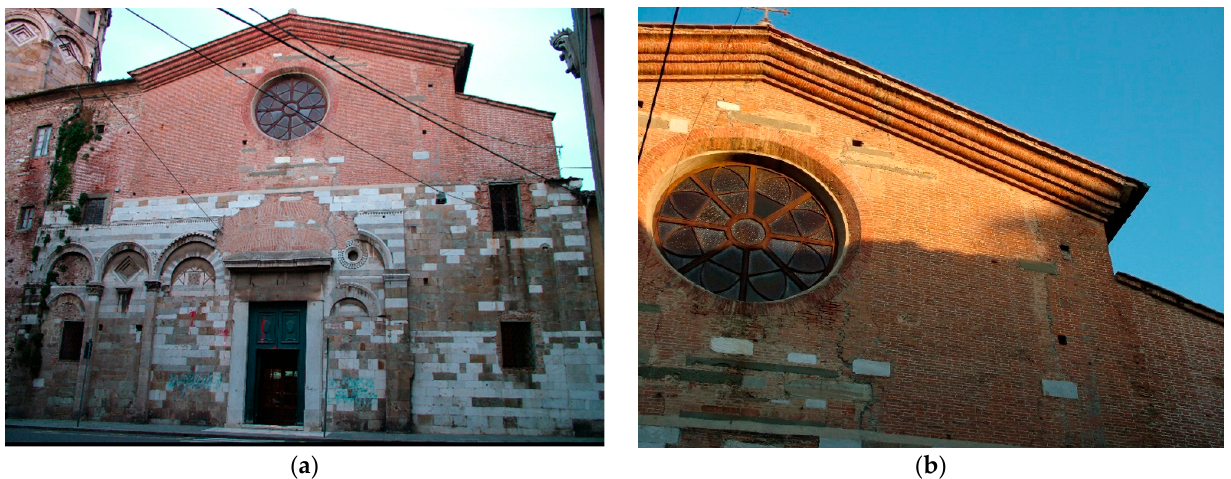
Figure 17. The crack pattern on the main façade: ( a ) general view; ( b ) detail.